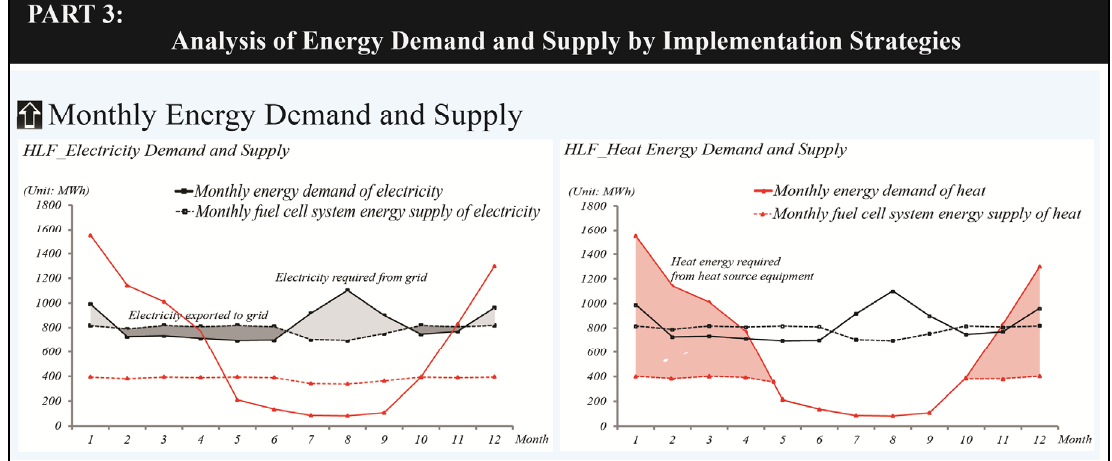
Figure 3. Graphical user interface of Part